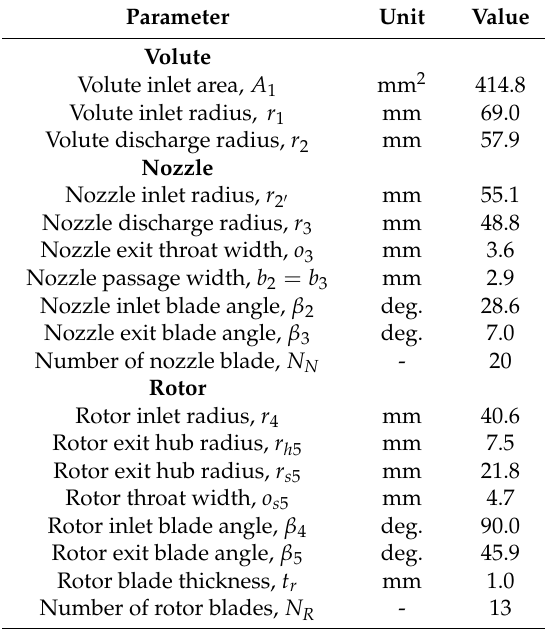
Table 4. Output dimensions from preliminary